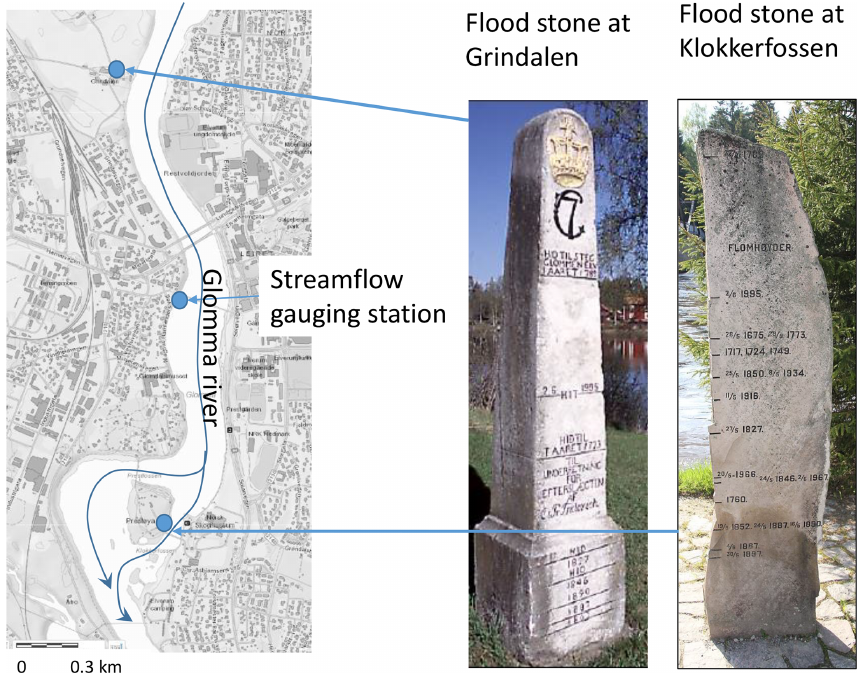
Figure 7. Map on the left shows the locations of the flood stones and the gauging station at Elverum (left, created at https://atlas.nve.no/ Html5Viewer/index.html?viewer=nveatlas#, last access: 18 November 2020). Pictures to the right show the flood monuments at Grindalen (middle, photo: N. R. Sælthun) and Klokkerfossen at the Norwegian forest museum (right, photo: Ø. Holmstad).